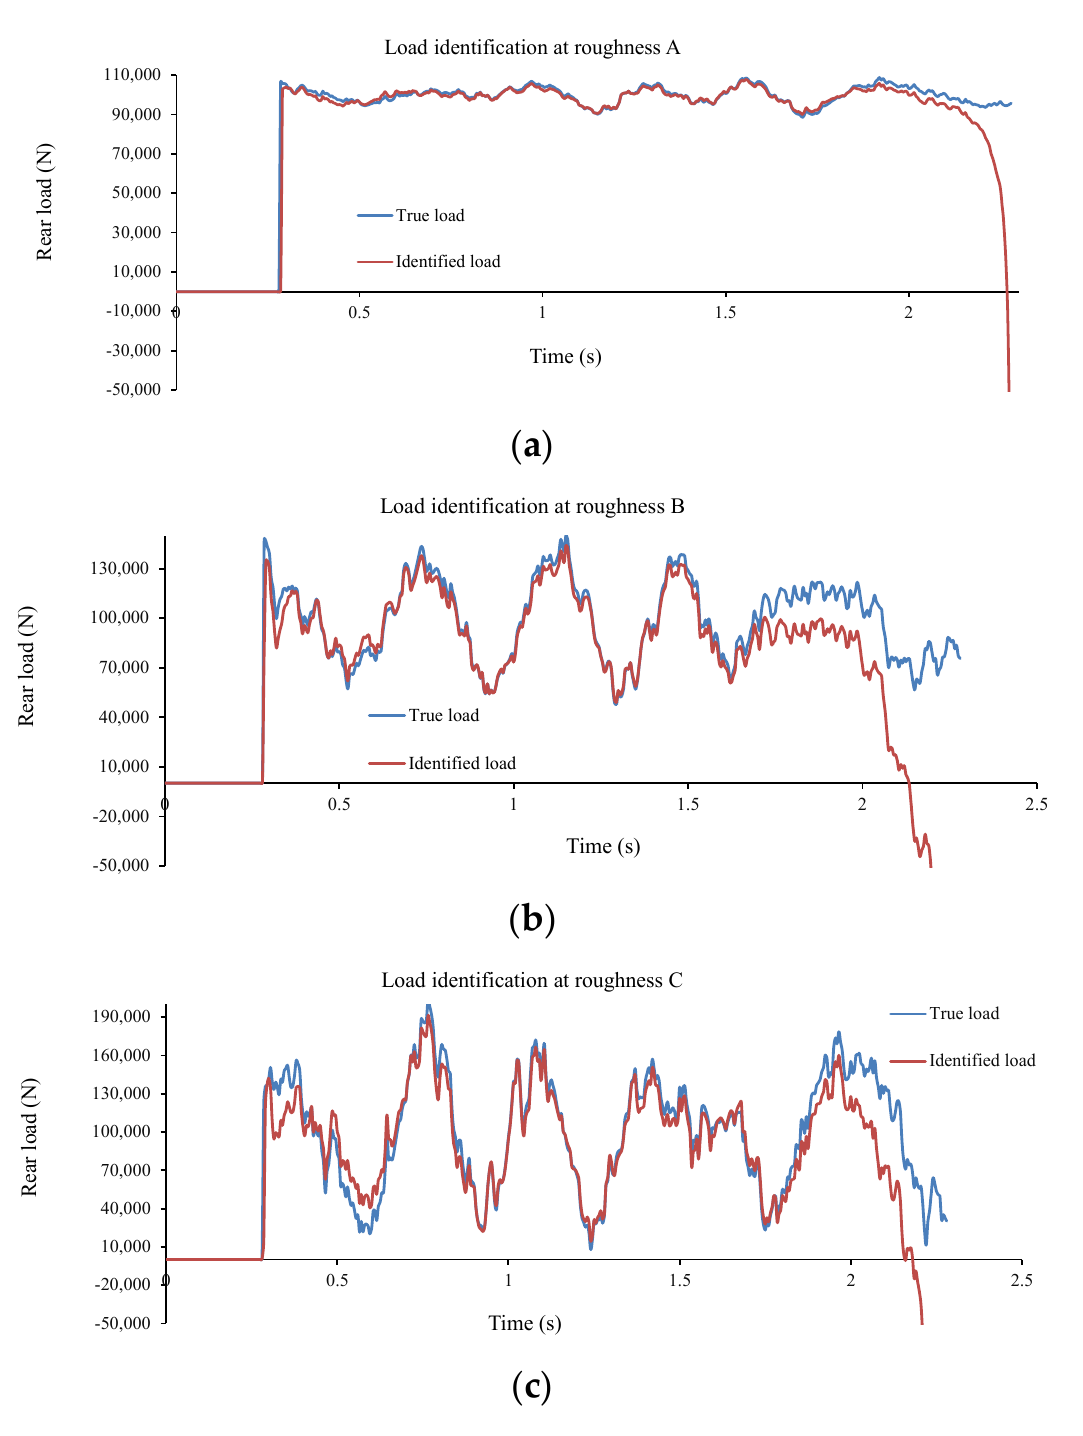
Figure 4. Rear load identification at road roughness levels A to C (speed 15 m/s). ( a ) roughness A; ( b ) roughness B; ( c ) roughness C.